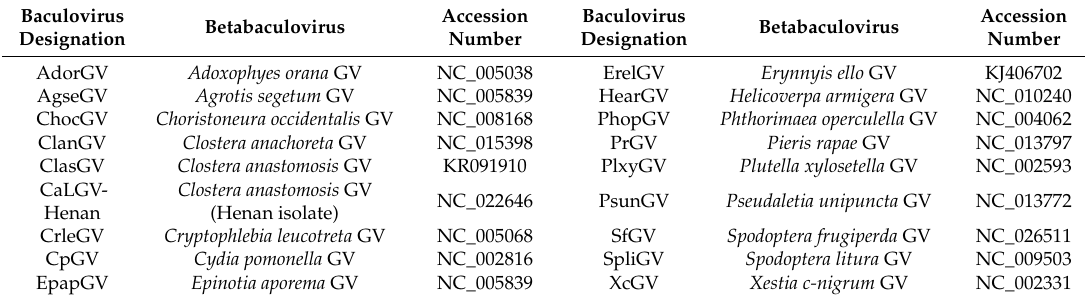
Figure 1. Maximum likelihood molecular phylogenetic analysis based on 37 core genes of granuloviruses. Betabaculovirus members (representatives of different clades) chosen for further experiments are marked in red. Table 1. Betabaculoviruses included in the phylogenetic analyses (Figure 1) for which genomes are available in GenBank database with their accession numbers and abbreviations.